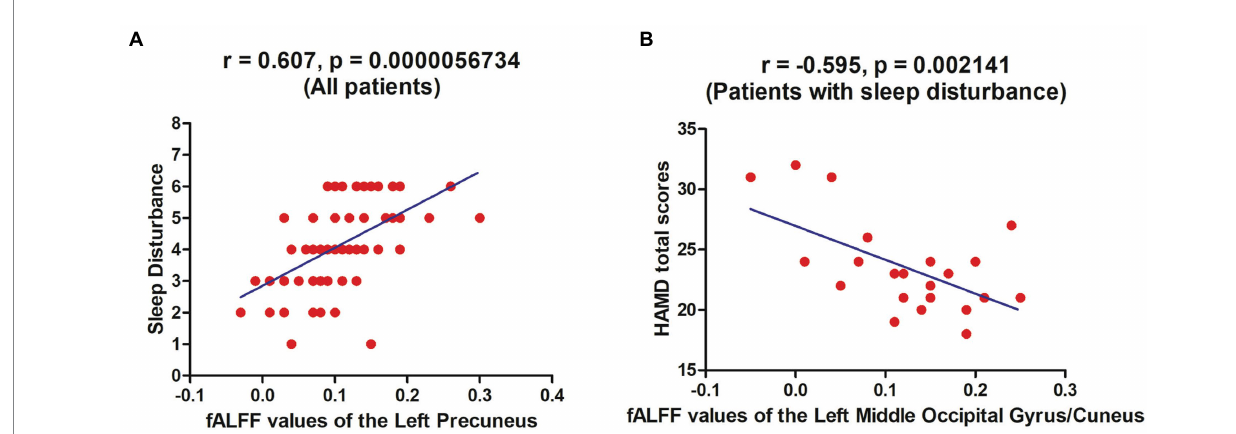
FIGURE 2 Correlations between fALFF values and clinical variables. For all patients with MDD, there was a positive correlation between fALFF values of the left precuneus and BAI scores (A) . For Pa_s , there was a negative correlation between fALFF values of the left middle occipital gyrus/cuneus and HAMD-17